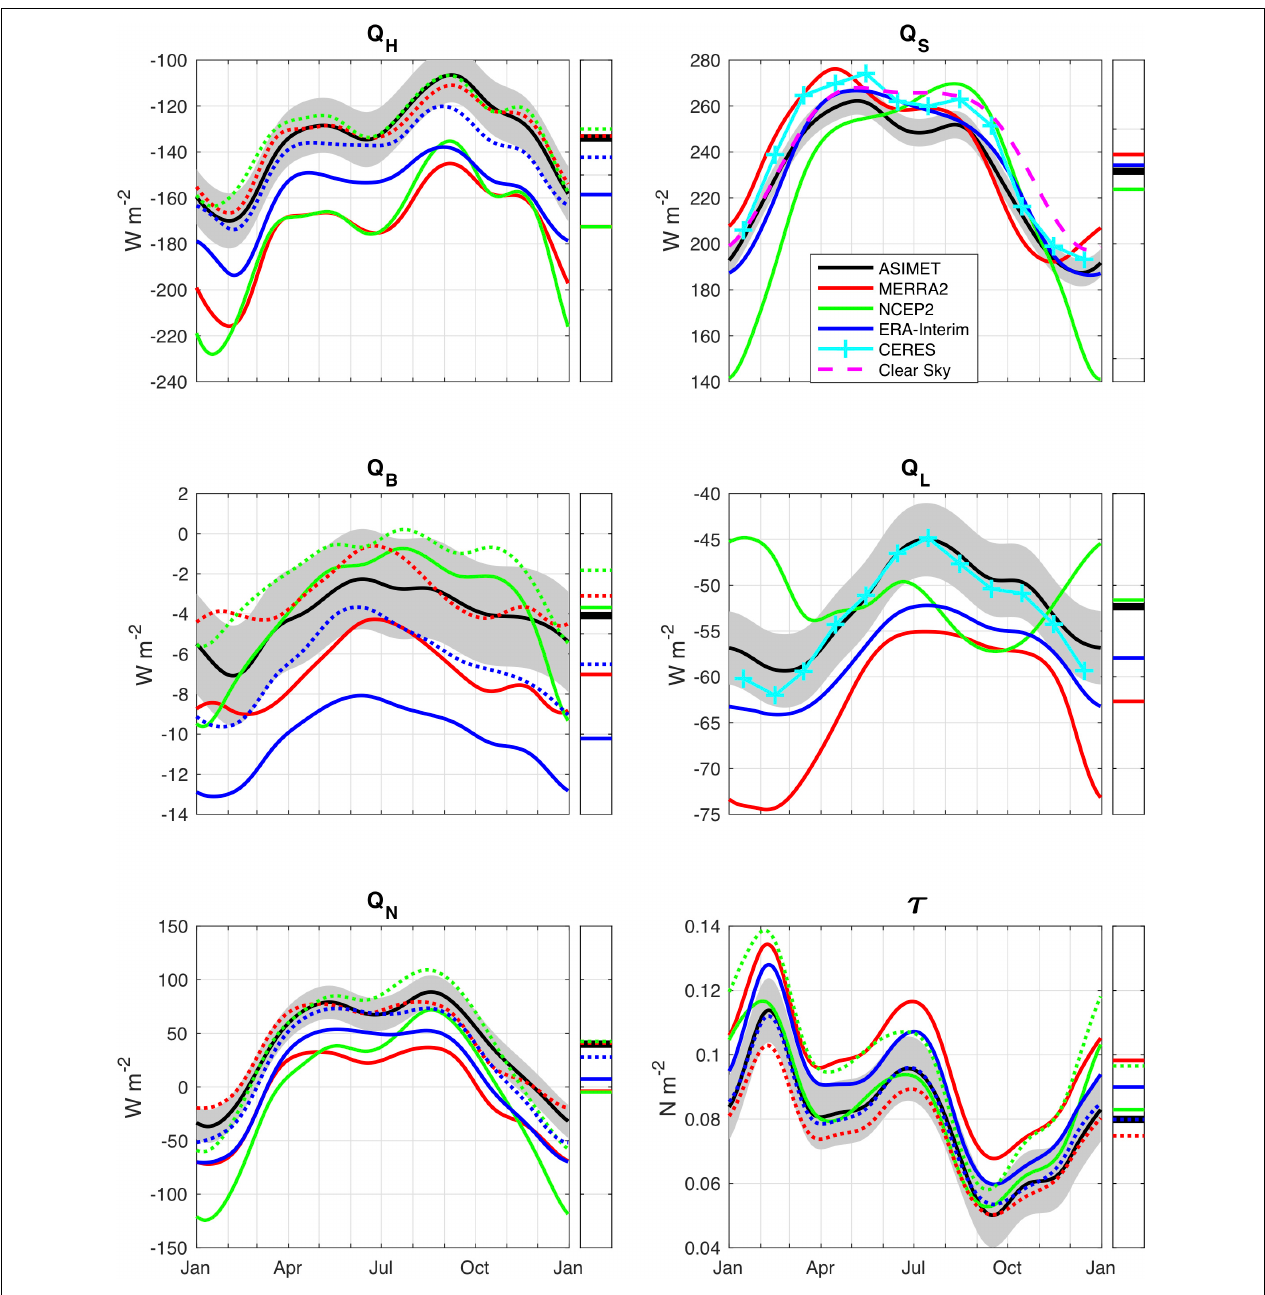
FIGURE 3 | Time-series of annual cycle of air-sea bulk fluxes at NTAS location, and annual averages on the right. Positive values mean heat input into the ocean. From left to right, top to bottom: latent heat, net shortwave radiation, sensible heat, net longwave radiation, net heat, wind stress. Gray shading indicates error associated with ASIMET measurements on the NTAS buoy. ASIMET (black), MERRA-2 (red), NCEP-2 (green), ERA-Interim (blue). Solid (dotted) lines denote native (hybrid) reanalyses fluxes. Based on daily data from April 1, 2001 through March 31,